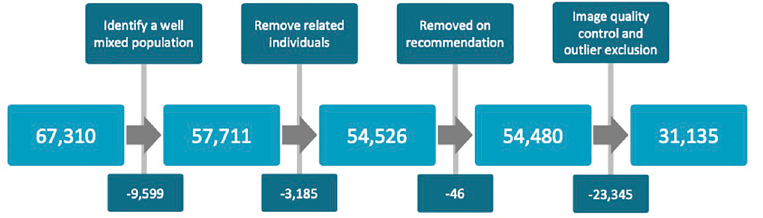
Fig 2. Cohort selection workflow. A schematic of the workflow applied during quality control of both genotypic and phenotypic